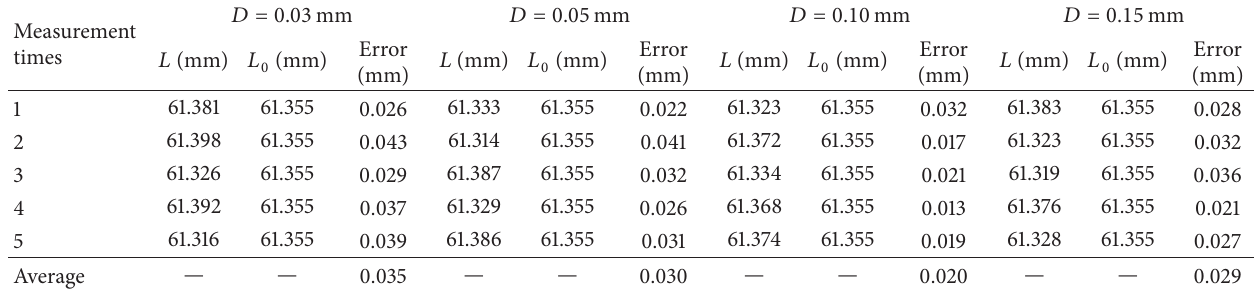
Table 1: Parameter “ 𝐷 ” experiment result.